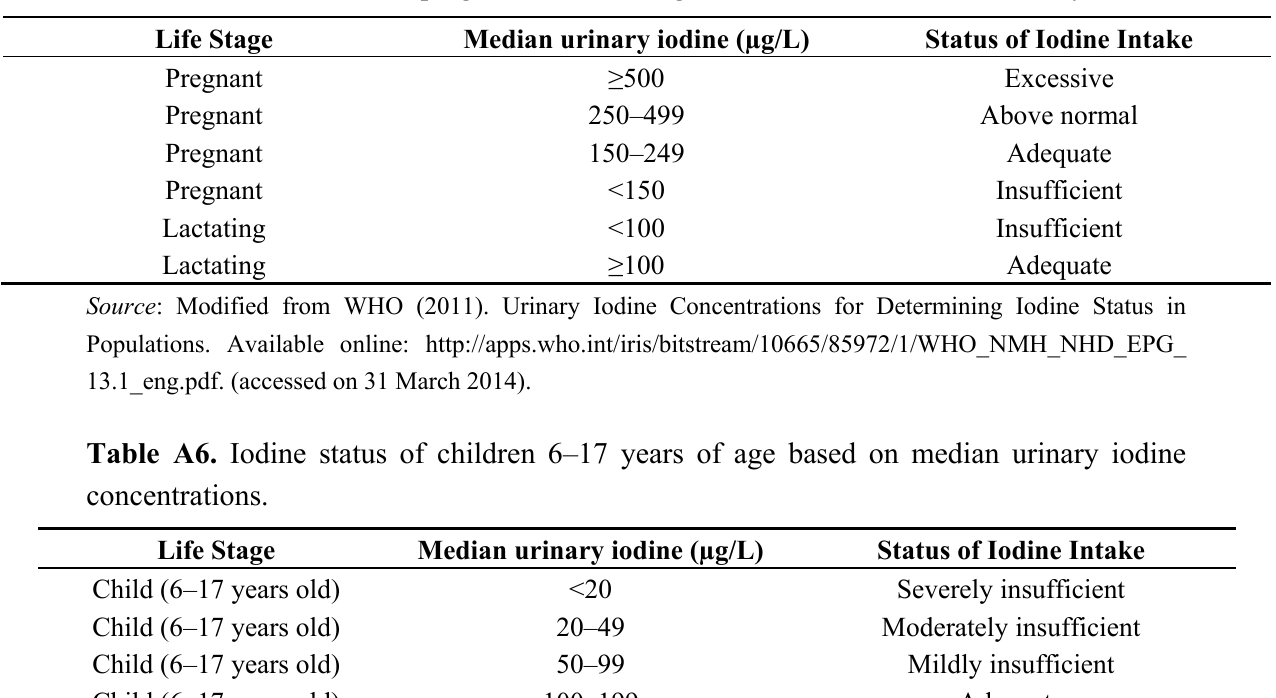
Table A5. Iodine status of pregnant and lactating women based on median urinary iodine.